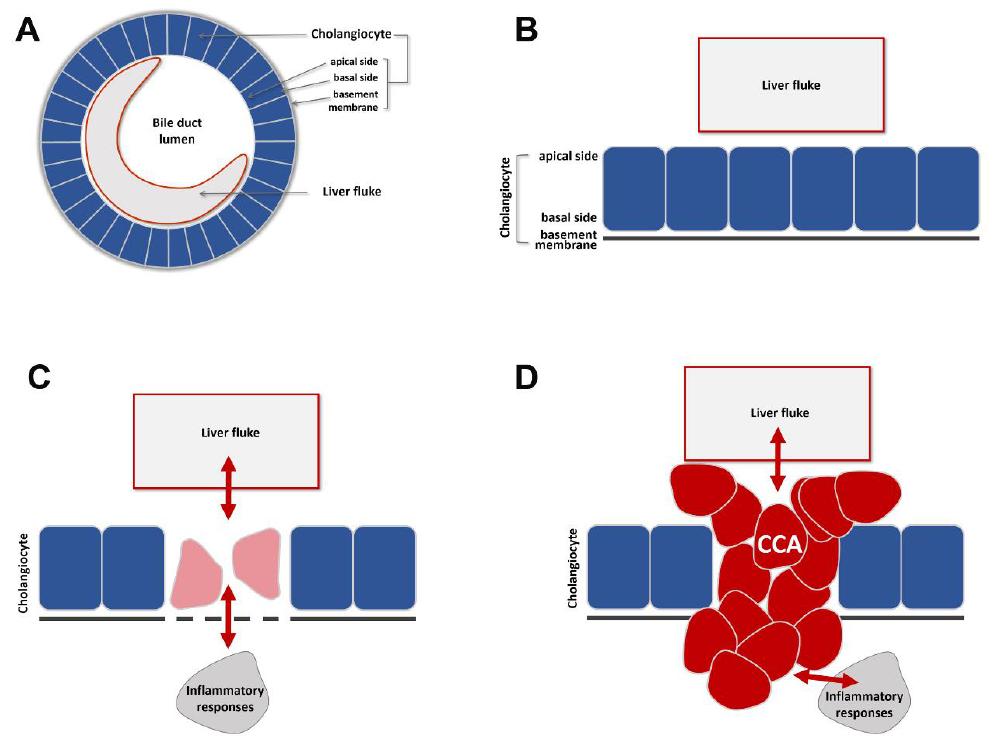
Figure 2. Schematic diagram of how fluke infection in the bile duct leads to CCA. ( A , B ) : An adult liver fluke resides within the lumen of a comparably sized bile duct. Bile duct epithelial cells are called cholangiocytes. Their apical surface faces the lumen and their basal surface is covered by a supporting, non-cellular basement membrane. ( C ): Fluke infection induces damage, repair, and other genetic and epigenetic changes in surrounding cholangiocytes. This may be mediated indirectly through host responses to infection. ( D ): CCAs arise as a consequence of chronic fluke